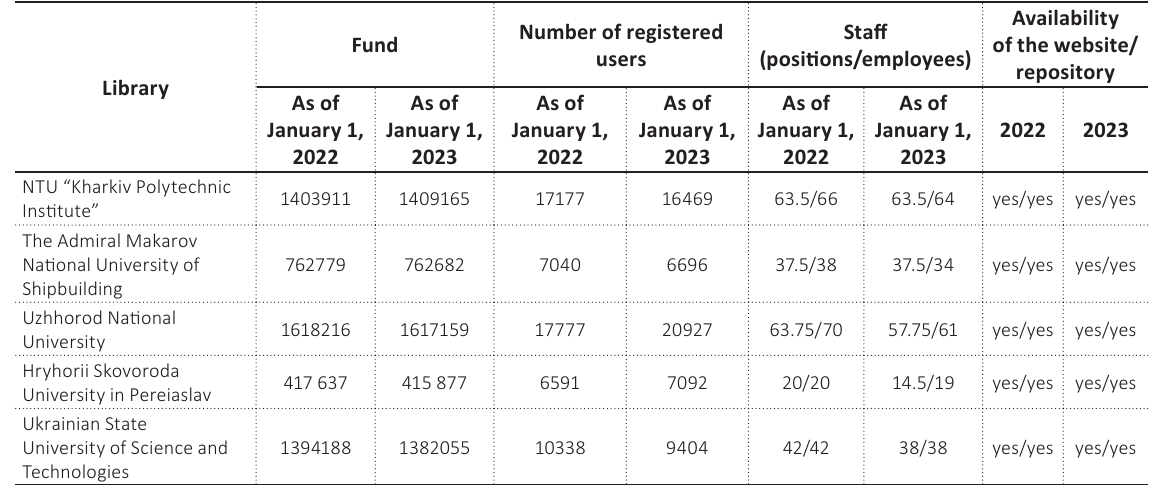
Table 1. Statistics of the university libraries of